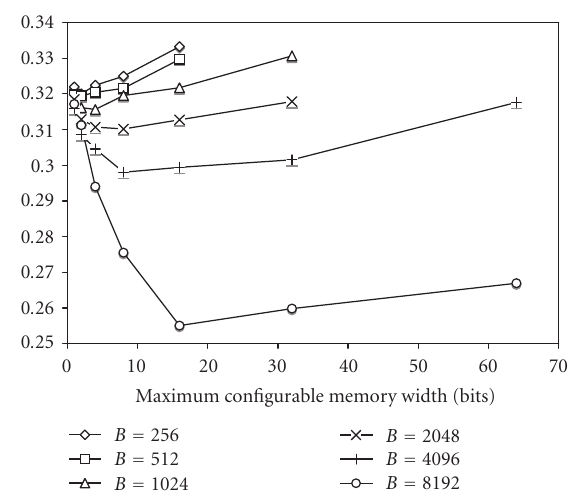
Figure 13: Impact on routing energy when increasing memory flex- ibility.